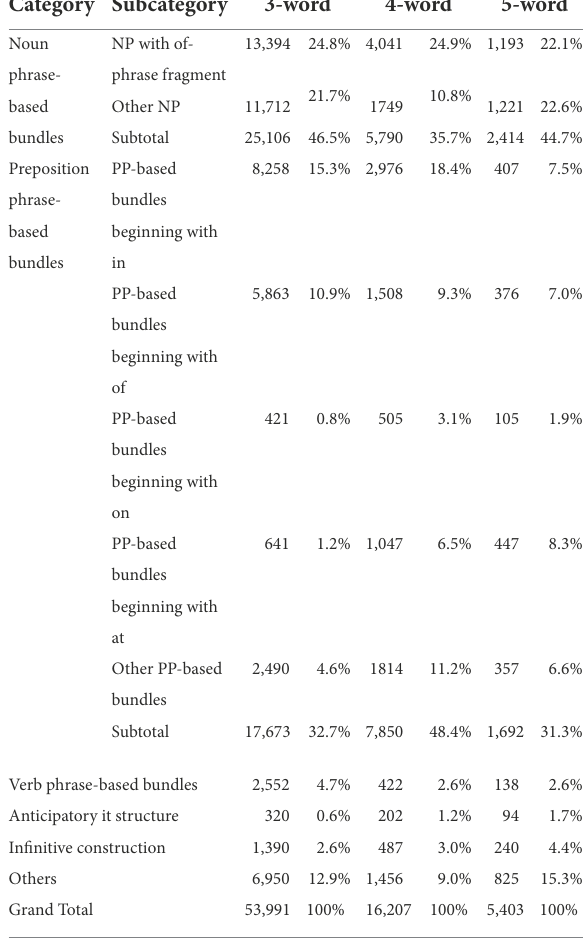
TABLE 4 Structural distribution of three-, four-, and five-word bundles. Category Subcategory